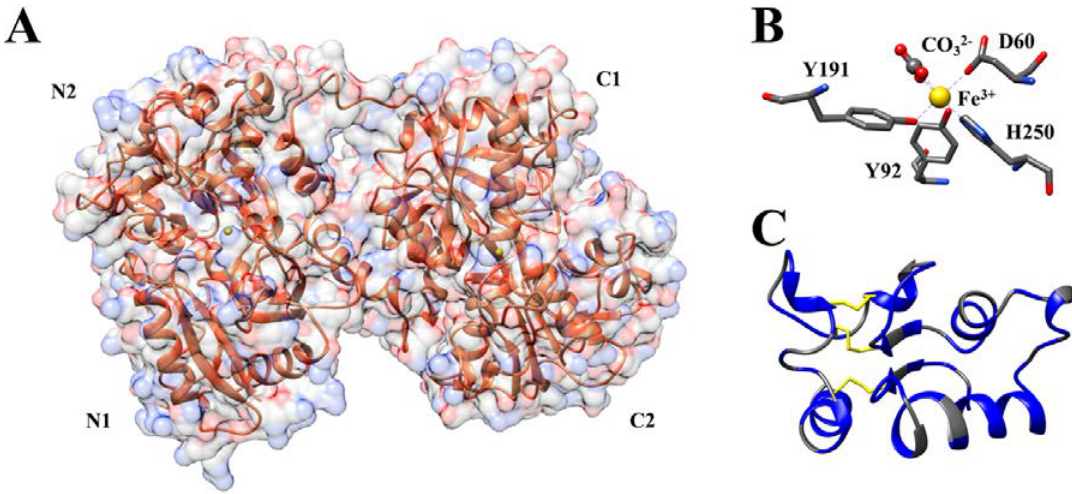
Figure 1. ( A ) Ribbon representation and the solvent-accessible surface (in transparency) of holo-Otrf (PDB ID:1OVT) [16]. N1, N2 and C1, C2 indicate the subdomains of each lobe. ( B ) The N-lobe iron binding site of hen’s ovotransferrin (PDB ID:1OVT). The amino acids involved in iron binding are shown in sticks. H-bonds are displayed by purple broken lines. Both in ( A ) and ( B ), the iron is indicated as a yellow sphere. ( C ) Schematic ribbon representation of the OTAP-92 peptide. The three disulfide linkages are represented in yellow, while the hydrophobic residues are highlighted in blue. The peptide is shown with the same conformation displayed in the intact protein. Molecular graphic images were produced using the UCSF chimera package [20].